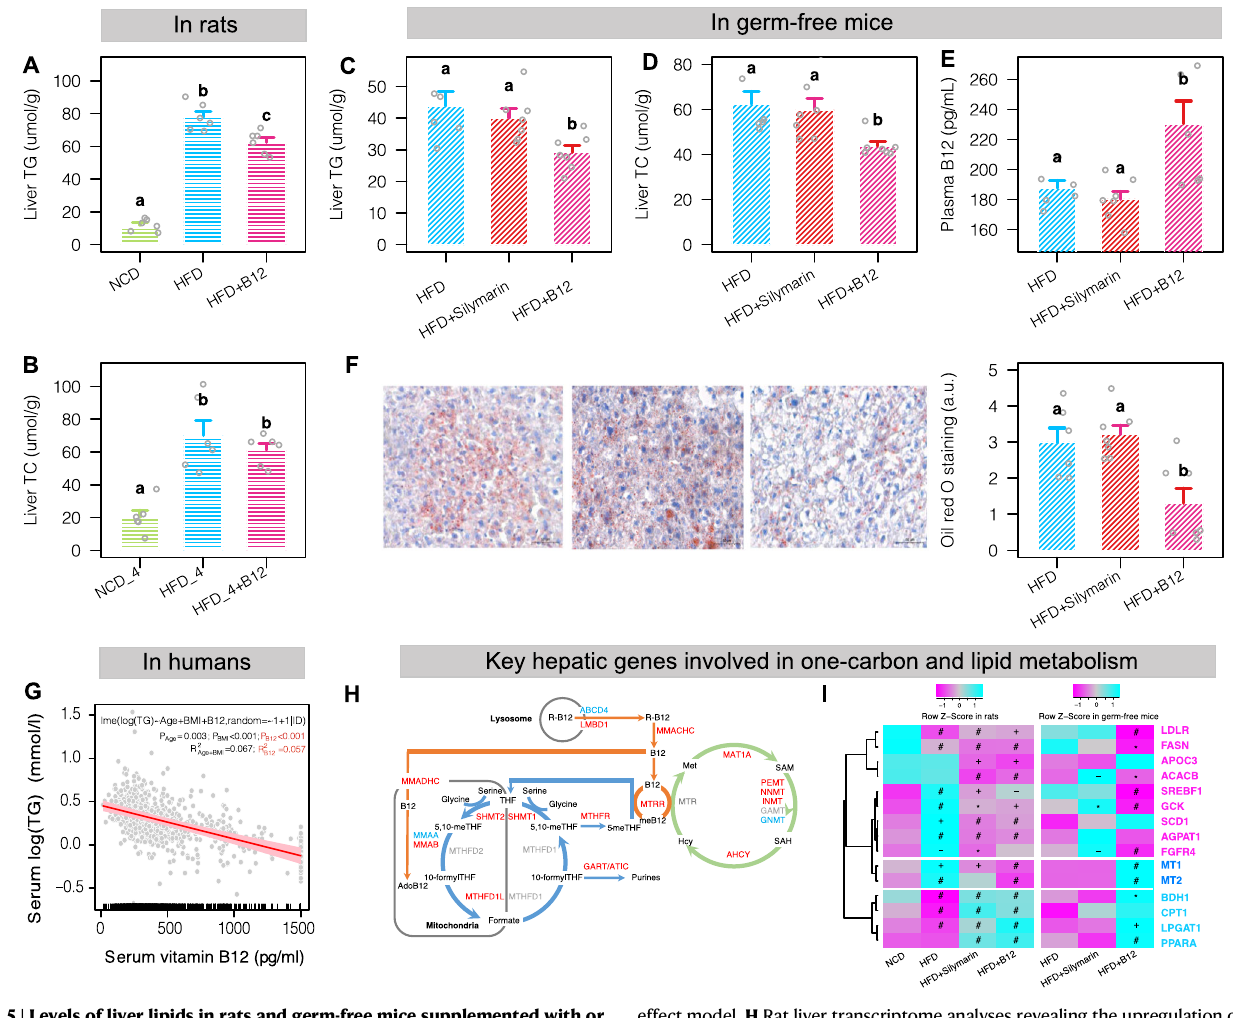
effect model. H Rat liver transcriptome analyses revealing the upregulation of key genes involved the one-carbon metabolism mediated by folate, B12, and the indicate P values smaller than 0.1, 0.05, 0.01, and 0.001, respectively). Wald test implantedinDESeq2packagewasusedforidenti fi cationofdifferentiallyexpressed genes and hypergeometric test was used for pathway enrichment analysis. For bar plots,valueswereshownasmean±S.E.M.Scalebar:50 μ